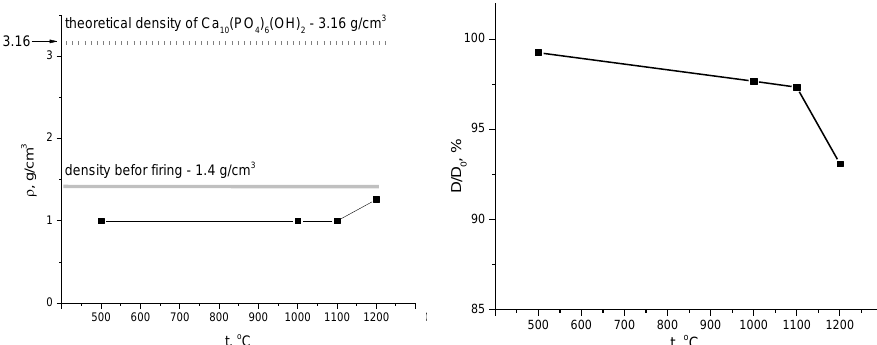
Figure 7. Apparent density (g/cm 3 ) and relative diameter (D/D 0 , %) of ceramic samples based on powder mixture (CaHPO 4 ·2H 2 O and CaC 2 O 4 ·H 2 O; non-identified quasi-amorphous phase) after firing at different temperatures.